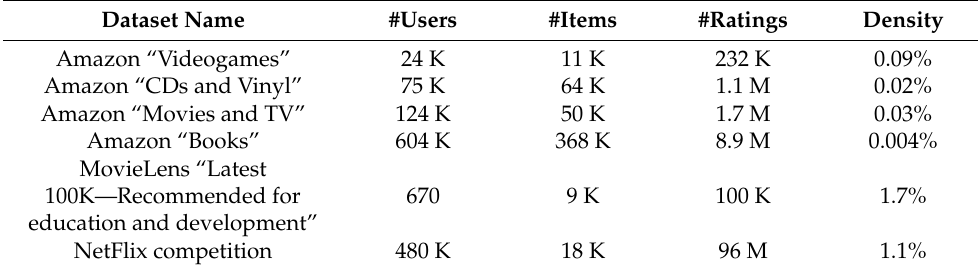
Table 1. Dataset information.